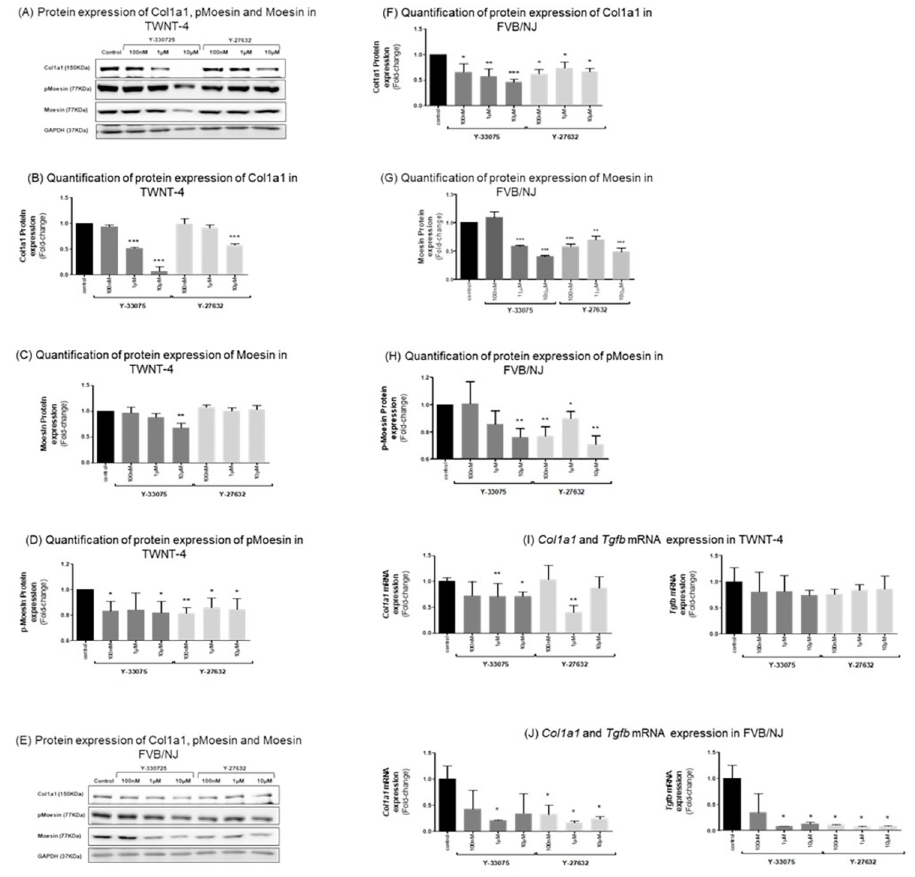
Fig 2. Y-27632 and Y-33075 treatments reduce fibrosis in human TWNT-4 and primary mouse HSCs. (A) Western blots of Col1a1, p-Moesin, Moesin and GAPDH using TWNT-4 cell lysates after 24 hour incubation with the ROCK inhibitors. (B) Quantification of protein expression of Col1a1 after treatment of TWNT-4 cells with ROCK inhibitors for 24 hours (n = 3). (C) Quantification of protein expression of Moesin after treatment of TWNT-4 cells with ROCK inhibitors for 24 hours (n = 3). (D) Quantification of protein expression of pMoesin after treatment of TWNT-4 cells with ROCK inhibitors for 24 hours (n = 3). (E) Western Blots of Col1a1, p-Moesin, Moesin and GAPDH using cell lysates of primary FVB/NJ cells after incubation with ROCK inhibitors for 24 hours. (F). Quantification of protein expression of Col1a1 after treatment of FVB/NJ cells with ROCK inhibitors for 24 hours (n = 3). (G) Quantification of protein expression of Moesin after treatment of FVB/NJ cells with ROCK inhibitors for 24 hours (n = 3). (H) Quantification of protein expression of p-Moesin after treatment of FVB/NJ cells with ROCK inhibitors for 24 hours (n = 3). (I) TWNT-4 mRNA expression levels of the pro-fibrotic marker Col1a1 and Tgf β (corrected to 18s as a housekeeping gene) after 24h incubation with ROCK inhibitors Y-27632 and Y-33075 (n = 3). (J) FVB/NJ mRNA expression levels of the pro-fibrotic marker Col1a1 and Tgf β (corrected to 18s as a housekeeping gene) after 24h incubation with ROCK inhibitors Y-27632 and Y-33075 (n = 3). Results are expressed as the mean ± standard error of the mean (SEM); � p < 0.05, �� p < 0.01 and ��� p <